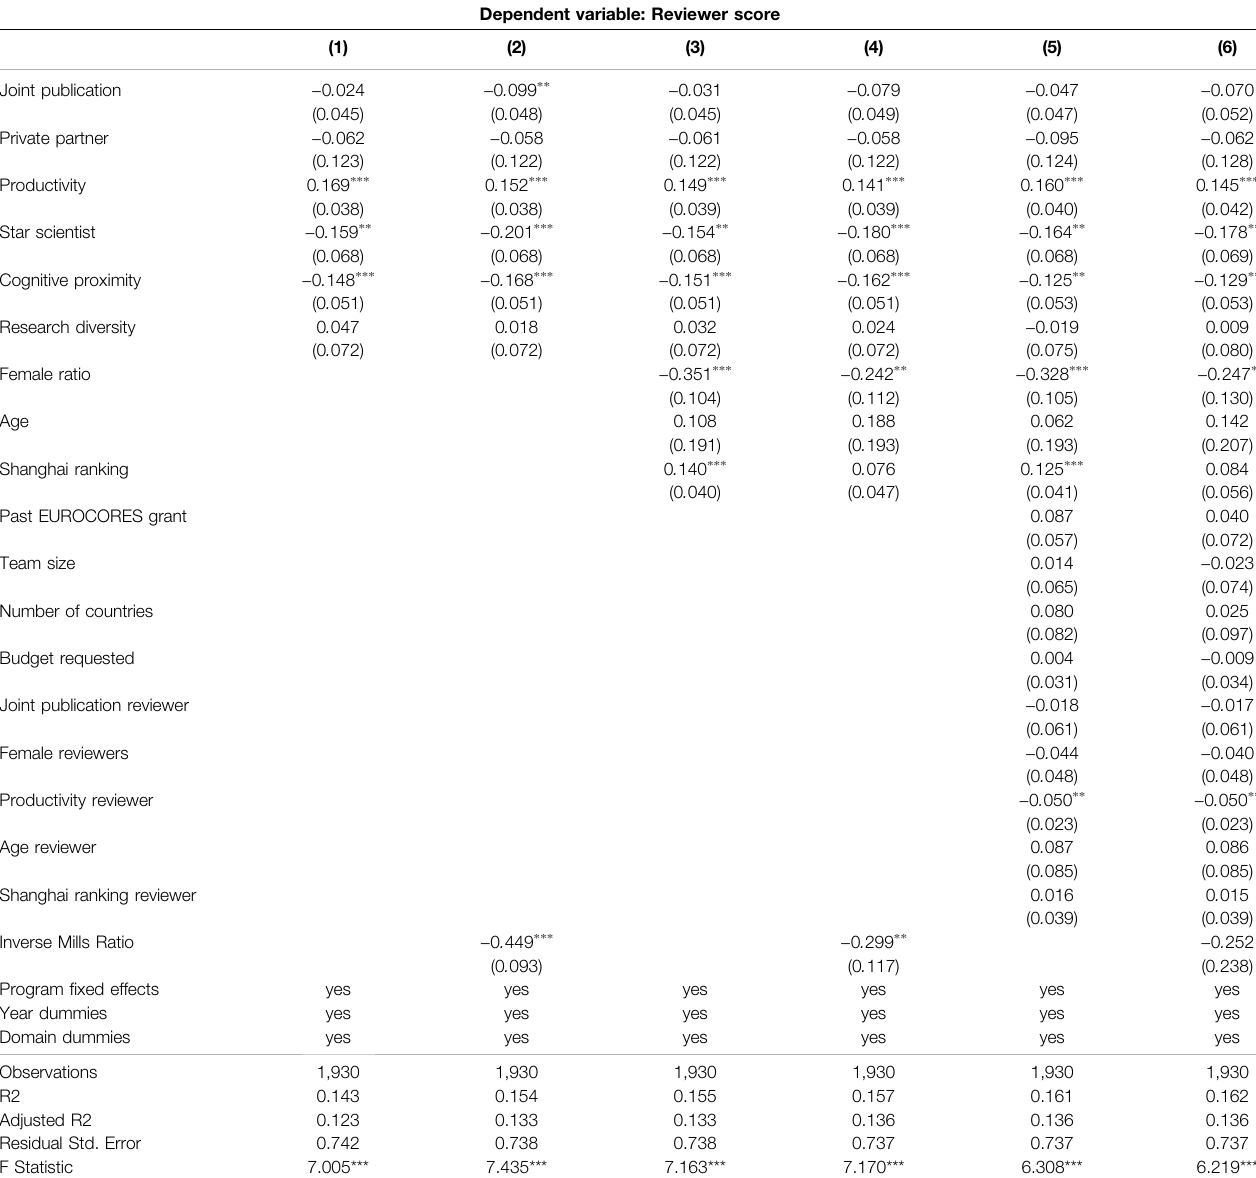
TABLE 9 | Second Stage — OLS regression